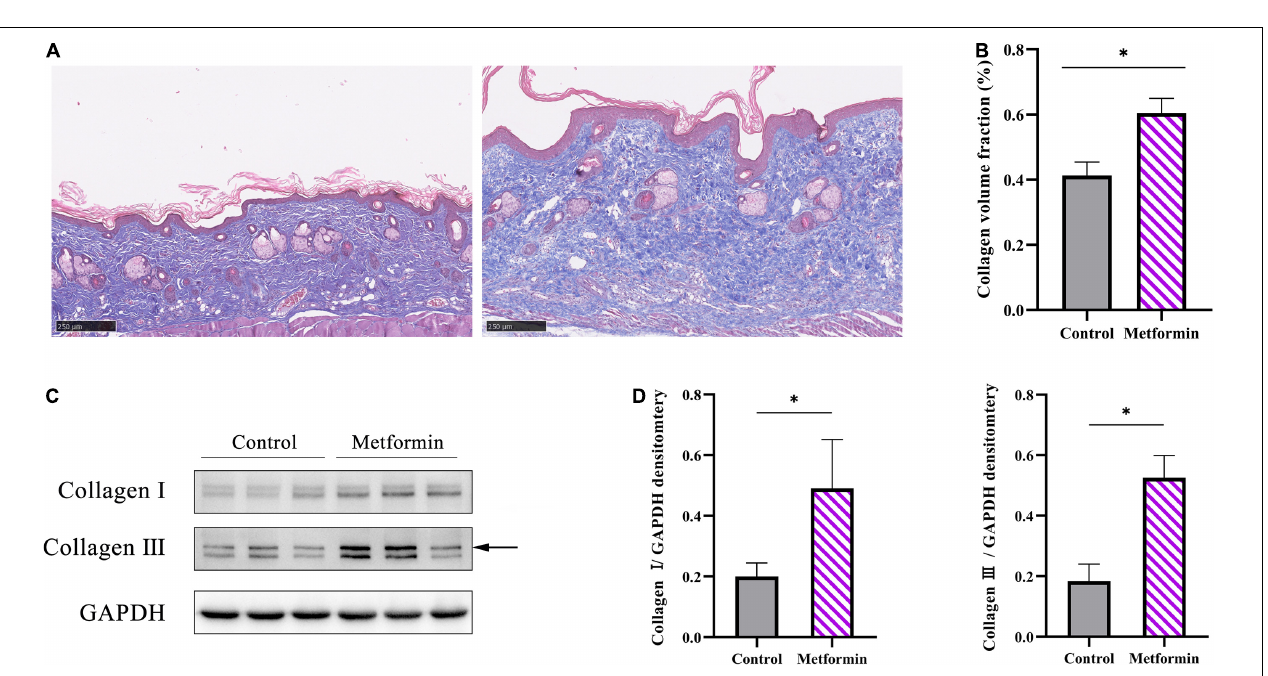
FIGURE 2 | Measurement of the thickness of mechanically stretched skin. (A) H&E staining of skin from the metformin-treated and control groups. Compared with the control group (top left), the metformin-treated group had more cell layers in the epidermis, with the cells closely arranged in the epidermal stratum basale layer (top right) and numerous hair follicles present in the metformin-treated group (bottom right). (B) Quantification of epidermal and dermal thickness. The epidermis and dermis in the metformin-treated group were significantly thicker than those in the control group. ∗ p < 0.05.